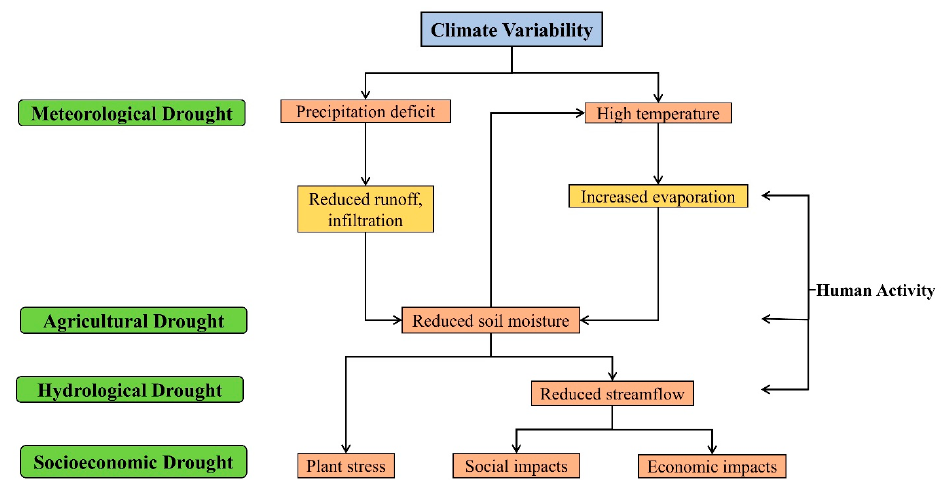
Figure 1. Climate-influenced relationships between hydrological cycle variables and drought types.